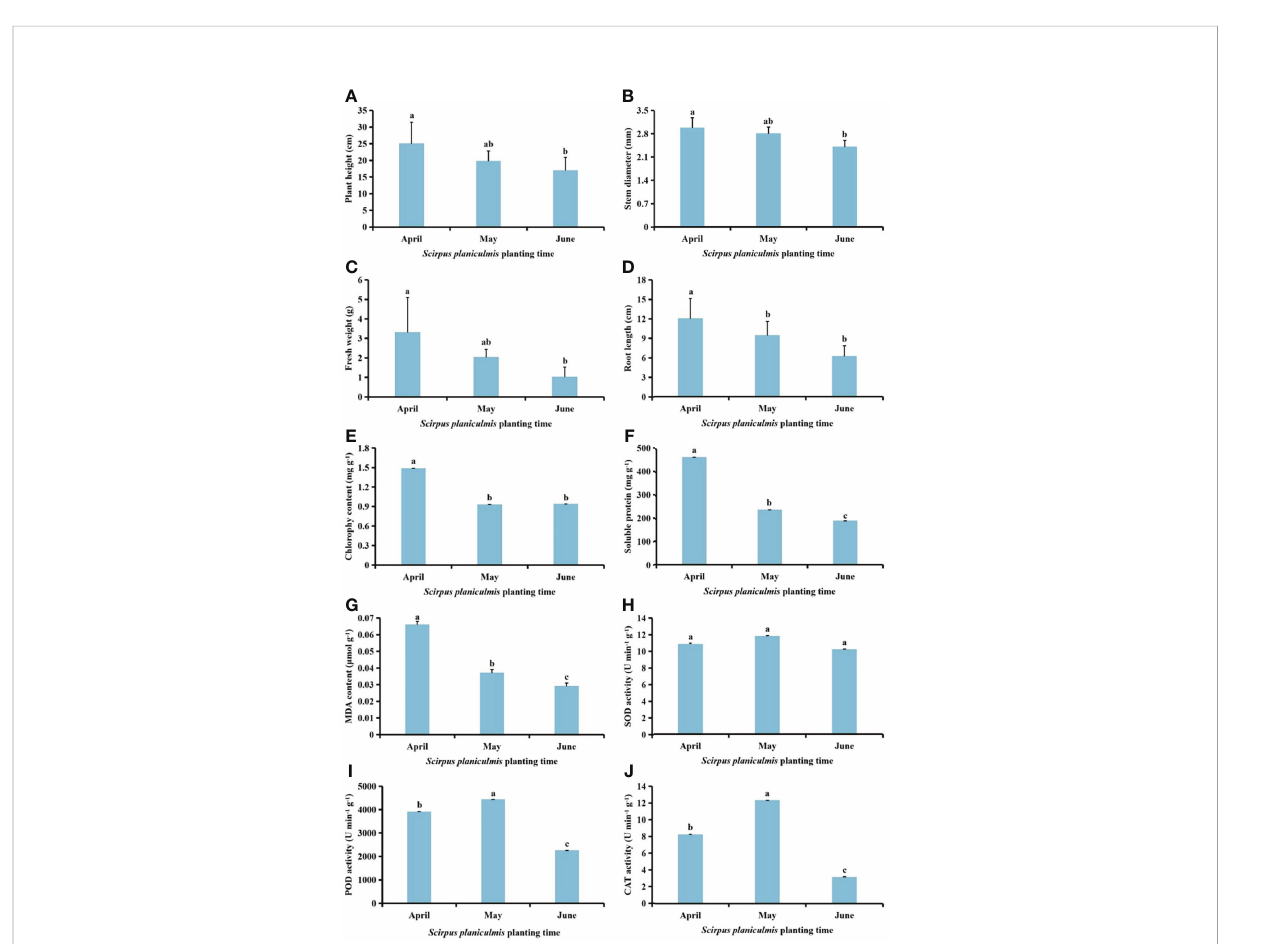
FIGURE 5 Effects of Scirpus planiculmis planting time on (A) plant height, (B) stem diameter, (C) fresh weight, (D) root length, (E) chlorophyll, (F) soluble protein and (G) malondialdehyde (MDA) content, and (H) superoxide dismutase (SOD), (I) peroxidase (POD) and (J) catalase (CAT) activities in S. planiculmis . The mean value ± standard data were presented in the fi gure. Different alphabetical letters indicate the signi fi cant differences between different S. planiculmis planting time ( p